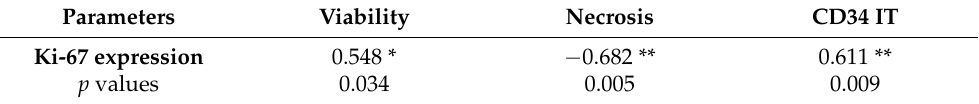
Table 9. Ki-67 cell proliferation correlates with viability, necrosis, and intratumoral CD34 expression.